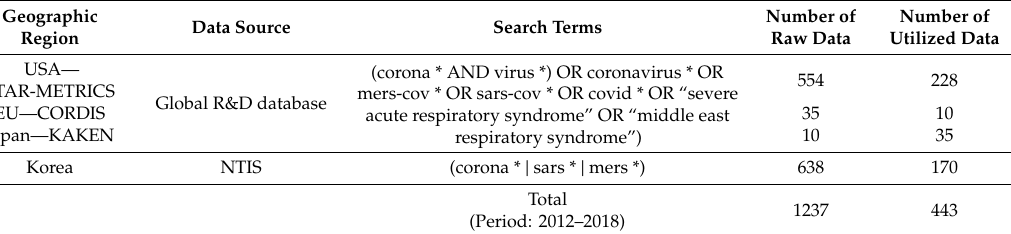
Table 1. The source of global R&D project